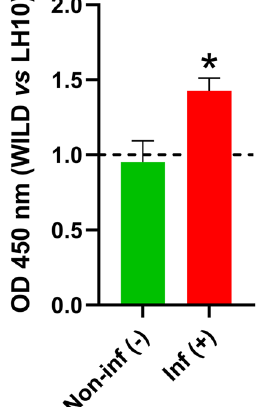
Figure 6. “Wild type” vs. LH10 ELISA showed the presence of IgG specific for LH10 peptide in sera from dogs infected with Dirofilaria repens . Levels of LH10-specific IgG in D. repens infected (red) and non-infected (green) dogs sera were compared to “wild type” M13 bacteriophage (dashed line). Plates were coated with 1.46 × 10 11 pfu/well of LH10/“wild type” clones in TBS. The blocking step was performed in 0.1 M NaHCO 3 , 0.5% BSA and plates were washed three times. Dogs sera were used in 1:800 dilution in blocking buffer. After six washes, secondary anti-dog IgG-HRP antibodies were used in a dilution of 1:50,000 in blocking buffer. The bars show mean ± SEM. The statistically significant differences between examined groups are marked with an asterisk: * p <